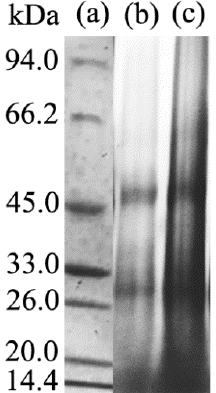
Figure 3. Gel electrophoresis test results. ( a ) protein molecular weight marker; ( b ) KF molecular weight distribution; ( c ) GKF molecular weight distribution.